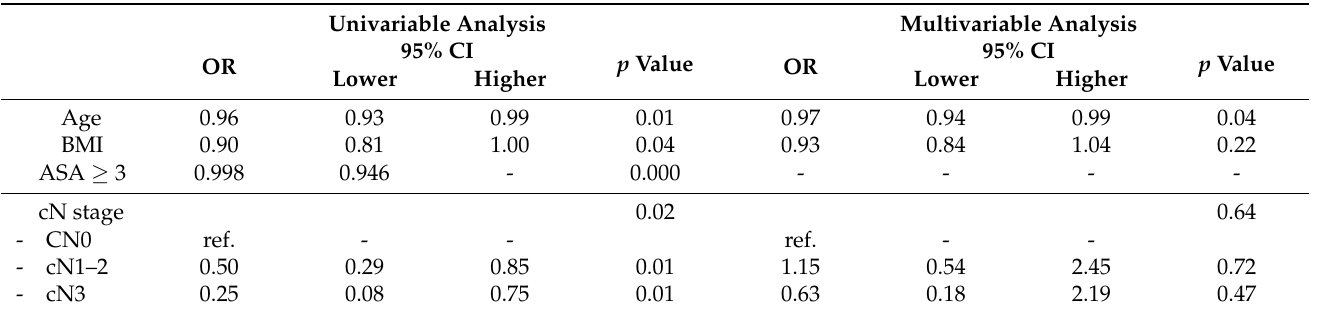
Table 2. Univariable and multivariable logistic regression analyses to identify predictors of Tetrafecta